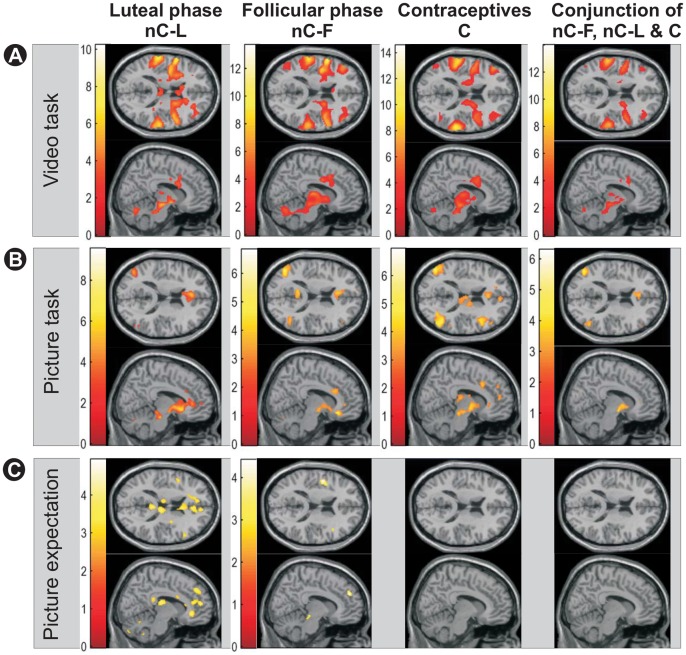
Differential brain activation contrasting erotic minus non-erotic stimulation.Depicted are contrasts from experimental runs with video (A), picture (B) and picture expectation (C) stimuli during luteal and follicular phase of the menstrual cycle and under oral contraceptives. The rightmost panel depicts the conjunction of the three conditions. For demonstration purposes, all thresholds were set at p<0.005 uncorrected. Even at such a more lenient threshold, no differential brain activation was found under contraceptives upon picture expectation.